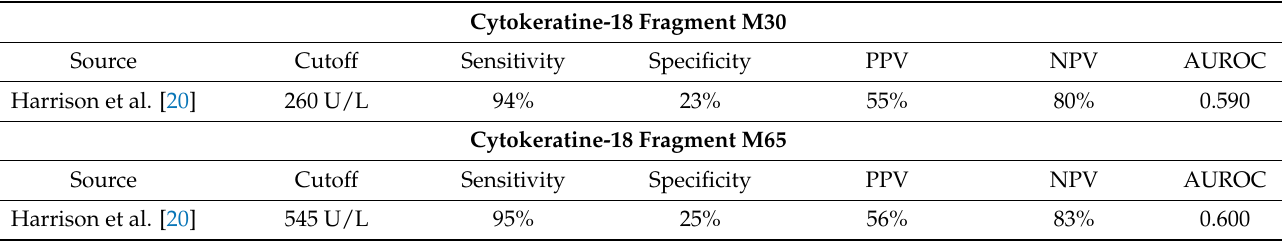
Table 9. Diagnostic performance of novel biomarkers in the detection of advanced